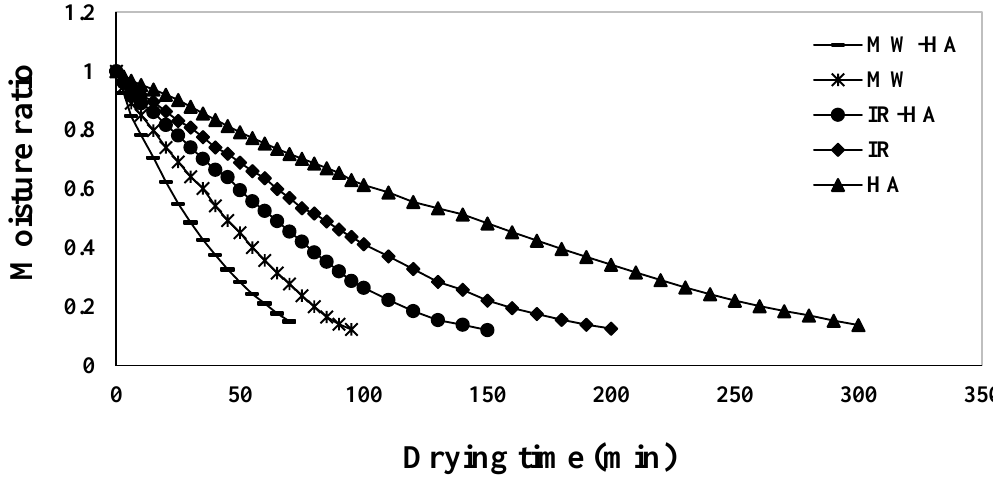
Figure 1. Drying kinetics of terebinth in di ff erent drying methods. Table 4. Analysis of variance (ANOVA) for the effect of drying methods on drying time, effective diffusivity ( D eff ), specific energy consumption (SEC ), color, rehydration ratio ( RR), and shrinkage (S b ) of terebinth. Table 6. Influence of di ff erent drying methods on drying parameters of